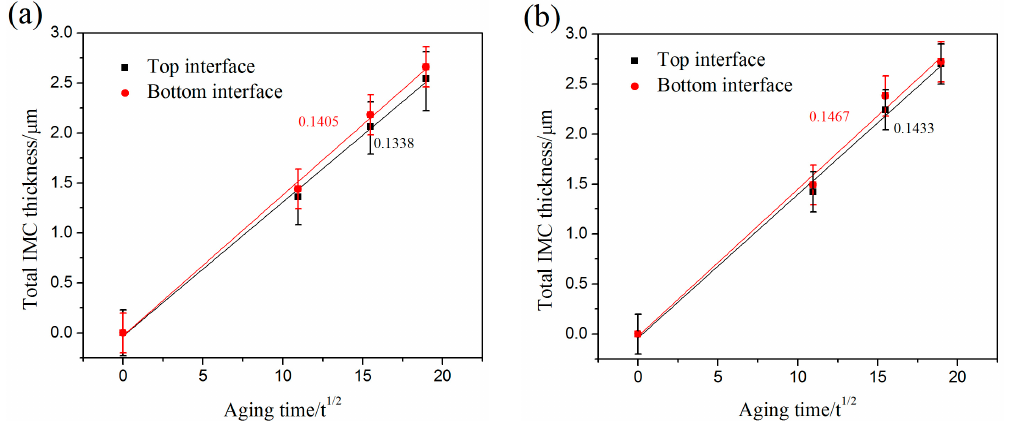
Figure 4. The total Cu 6 Sn 5 and Cu 3 Sn thickness of the top and bottom interfaces with aging time at different bonding times: ( a ) 400 ms and ( b ) 800 ms.